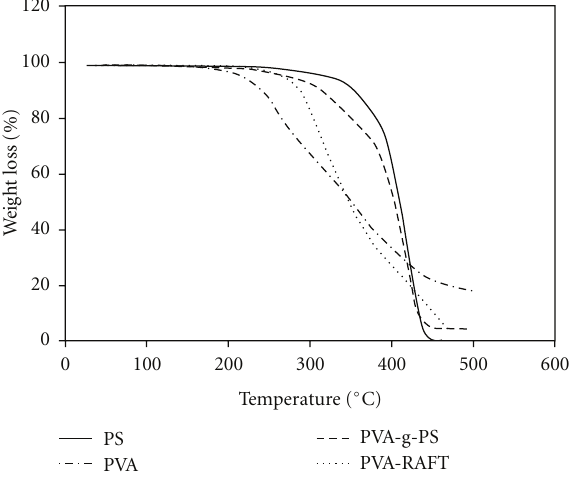
Figure 12: Compared TGA thermogram of